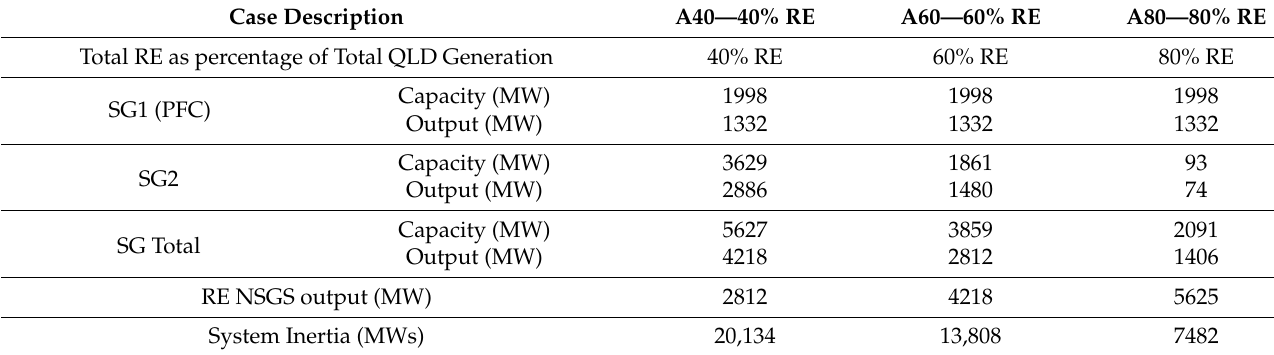
Table 3. Parameters for Group A case studies.